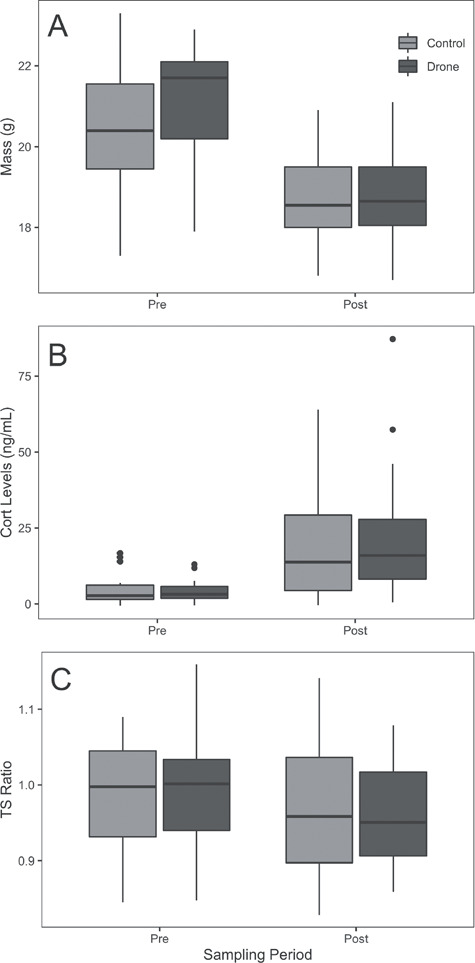
Physiological data. (A) Change in mass: neither sampling period nor treatment had significant differences. (B) Change in baseline corticosterone: no significant difference between sample or treatment in baseline CORT levels. To increase visual acuity, we removed one outlier in the post experimental control group at 124.27 ng/ml. (C) Change in relative telomere length: no significant difference between sample or treatment in the rate of telomere shortening.